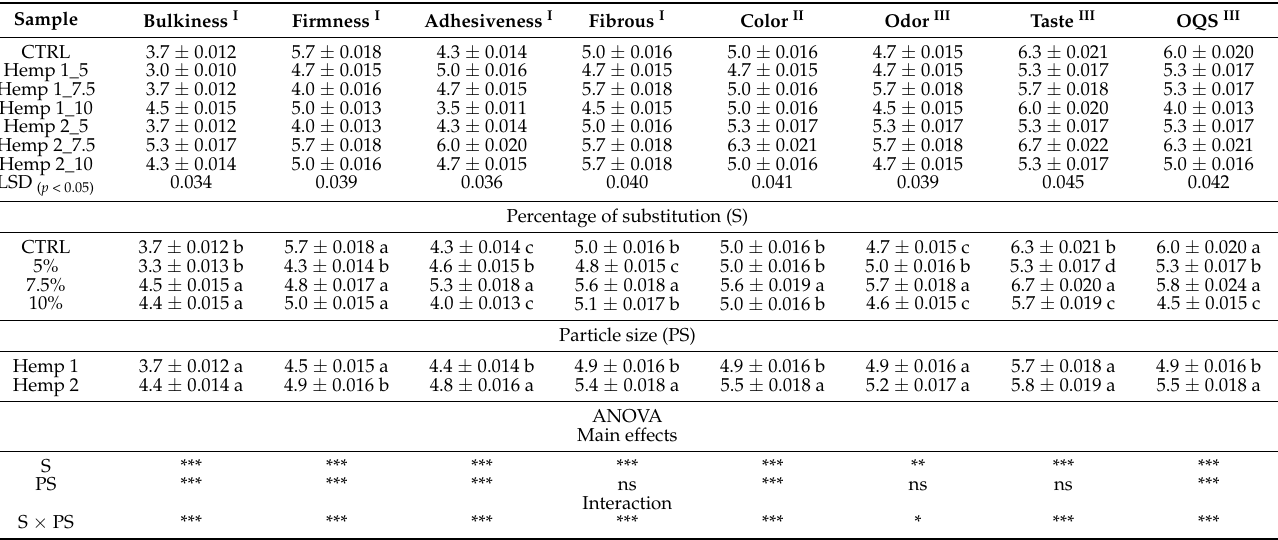
Table 9. Sensory characteristics of cooked pasta.